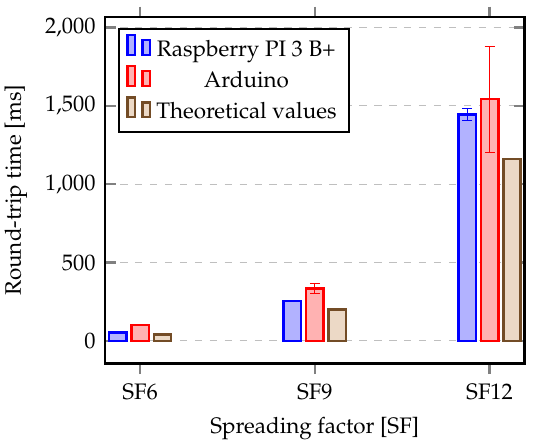
Figure 12. Round-trip time (average and standard deviation) evaluation for different spreading factors.